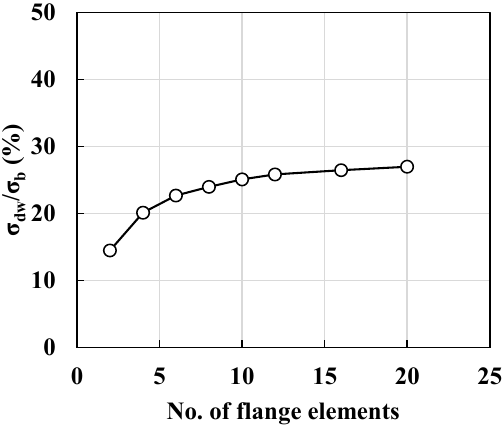
Figure 4. Comparison of the FEA and literature [9]. ( a ) Load and boundary conditions of the FEA model, ( b ) comparison of the FEA results and literature under a concentrated load case (LC1), and ( c ) comparison of the FEA results and literature under a distributed load case (LC2). To achieve convergency of the FEA results, the fine mesh size, which is sixteen element numbers along the flange, was used based on the sensitivity analysis. The same mesh sizes along both longitudinal directions of the girders and vertical direction (web line) were used. The sensitivity analysis results are presented in Figure 5.